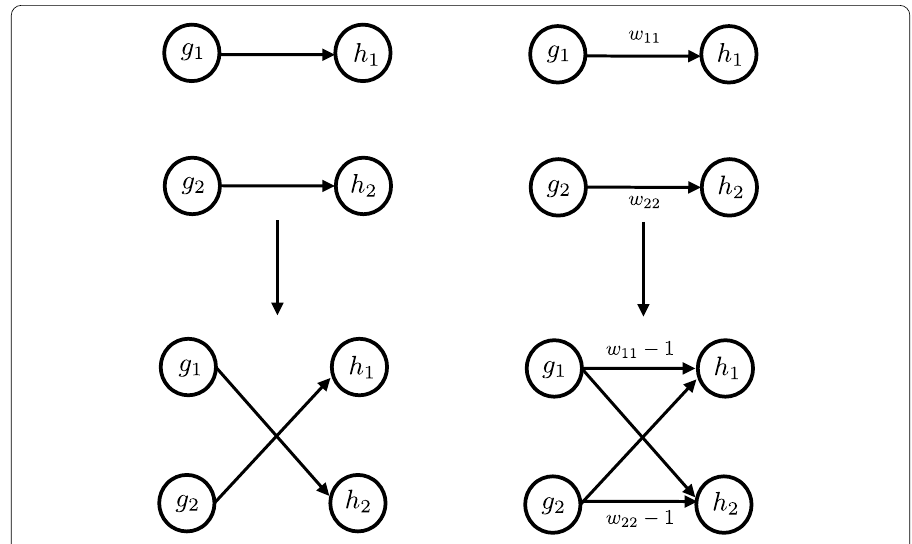
Figure 1 xSwap rewiring moves. Left: swap of two links with unit weight. Right: swap of a unit weight subtracted from two links with weights larger than